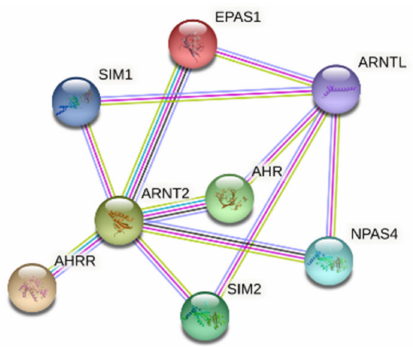
Figure 7. STRING-based interactome between selected representatives of bHLH-PAS transcription factor (TF) proteins (an internal protein-protein interaction network (PPI)). In the corresponding STRING-generated network, the nodes correspond to proteins, whereas the edges show predicted or known functional associations. Seven types of evidence are used to build the corresponding network, where they are indicated by the differently colored lines: a green line represents neighborhood evidence; a red line—the presence of fusion evidence; a purple line—experimental evidence; a blue line—co-occurrence evidence; a light blue line—database evidence; a yellow line—text mining evidence; and a black line—co-expression